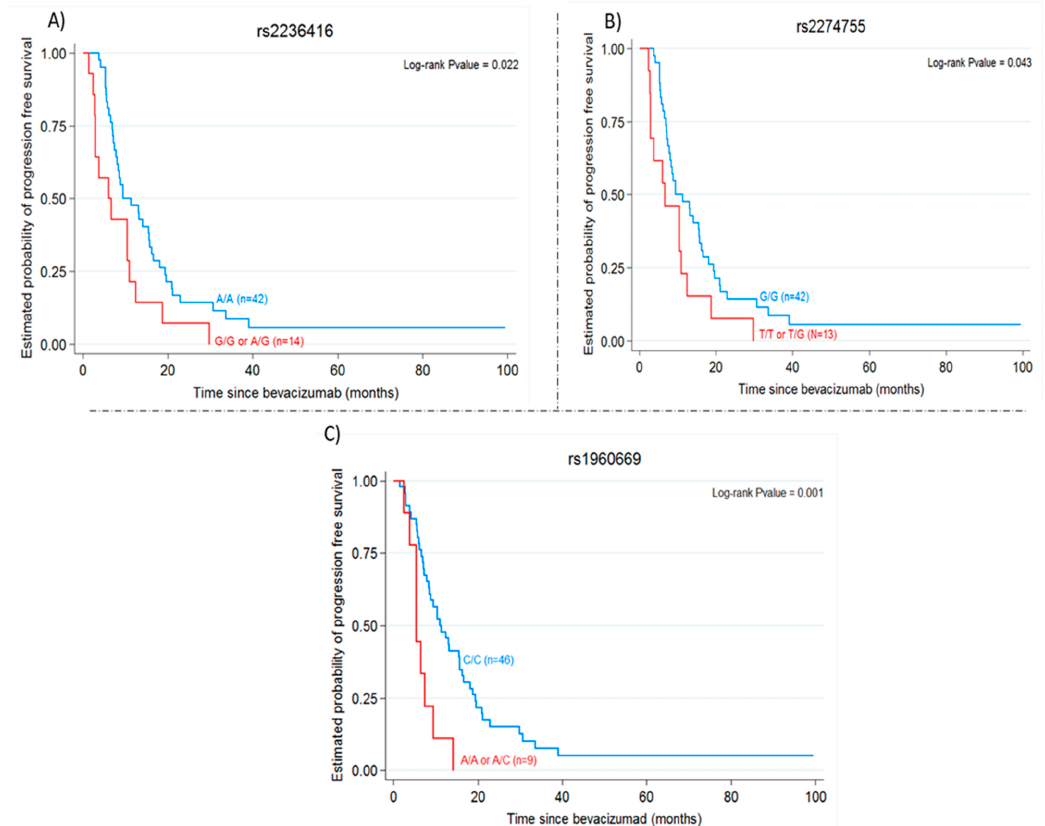
Figure 1. ( A ) PFS in response to bevacizumab treatment in patients with MMP9 rs2236416 A/A vs. A/G /GG (9.48 vs. Figure 1. A . PFS in response to bevacizumab treatment in patients with MMP9 rs2236416 6 months, p = 0.022). ( B ) PFS in response to bevacizumab treatment in patients with MMP9 rs2274755 G/G vs. G/T /TT (9.48 vs. 6.82 months, p = 0.043). ( C ) PFS in response to bevacizumab treatment in patients with FGF2 rs1960669 C/C vs. Int. J. Mol. Sci. 2021 , 22 , x FOR PEER REVIEW C/A /AA (10.95 vs. 5.44 months, p = 0.001).